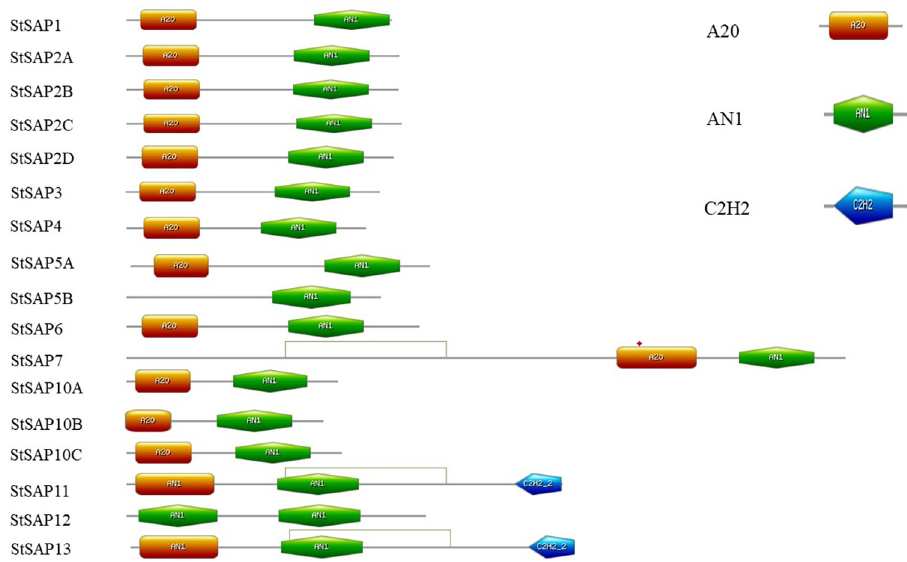
Fig 2. Distribution of conserved motifs in S . tuberosum SAP family.